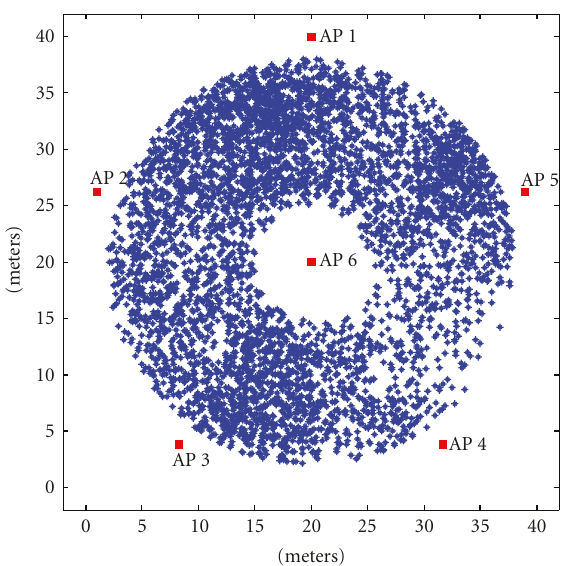
Figure 3: Simulation scenario (40 × 40 m 2 ) with 6 anchors placed on the vertices and centre of a regular pentagon. The blue stars represent the actual MS